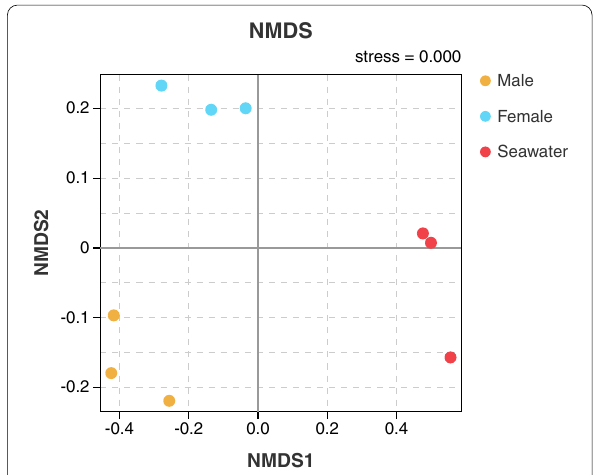
Fig. 2 NMDS analysis based on Bray-Curtis distance showing microbial community composition differences between male, female Porphyra haitanensis and